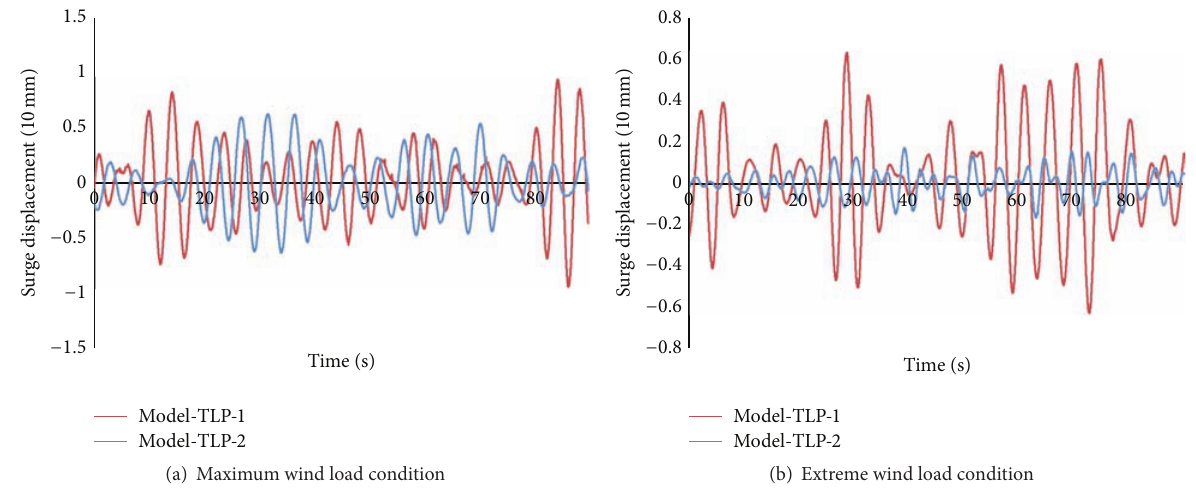
Figure 14: Model-TLP-1 and model-TLP-2 surge displacement for different load conditions.